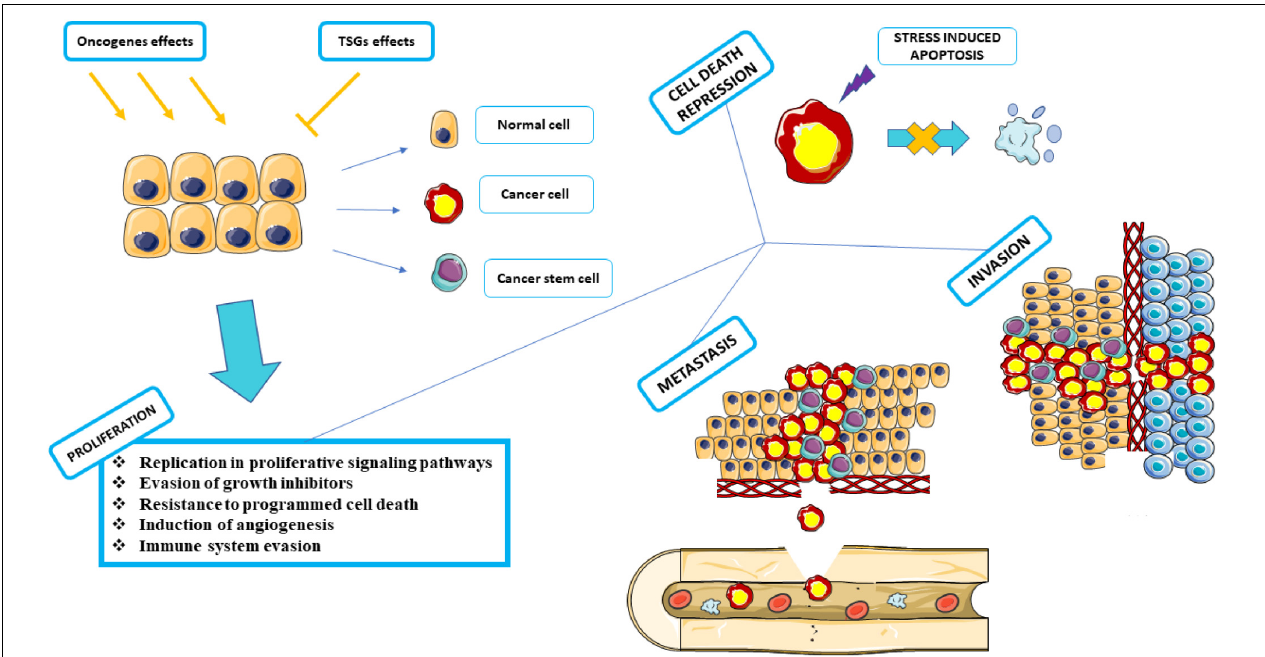
FIGURE 4 | Proliferation, Cell death repression, Metastasis, and Invasion. Under the influence of activated or proliferated oncogenes, cells progress to cancer by inhibiting the activity of tumor suppressor genes. Various factors can act as carcinogens, including chemical carcinogens, physical carcinogens, and oncogenic viruses. Cancer cells must go through several stages in proliferation to arrive at the subsequent phases. Neutralizes apoptosis by inhibiting programmed cell death. It attacks adjacent tissues and expands its dominance by invasion. It metastasizes through the circulatory system and moves from the blood vessels or lymphatic system to various parts of the body, away from the source of its formation, and spreads throughout the organs. This graphical figure was created using the vector image bank of Servier Medical Art (http://smart.servier.com).